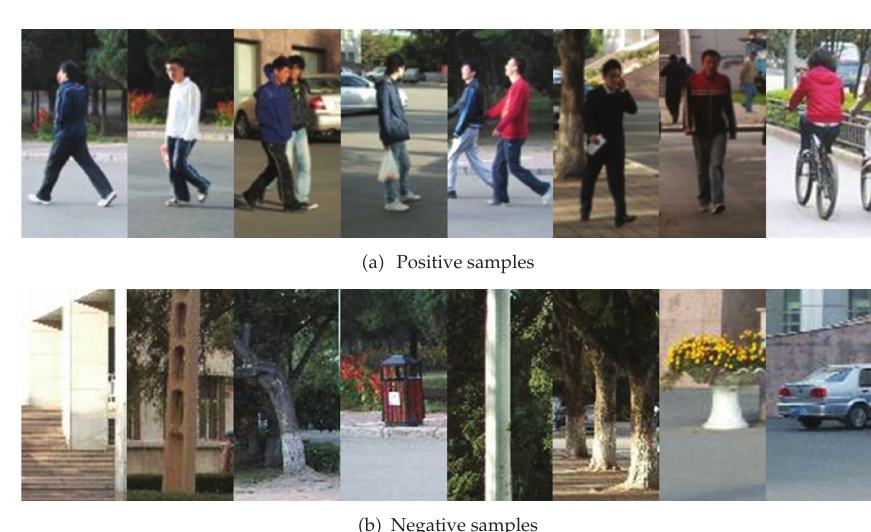
Figure 8: Partial samples in RSPerson